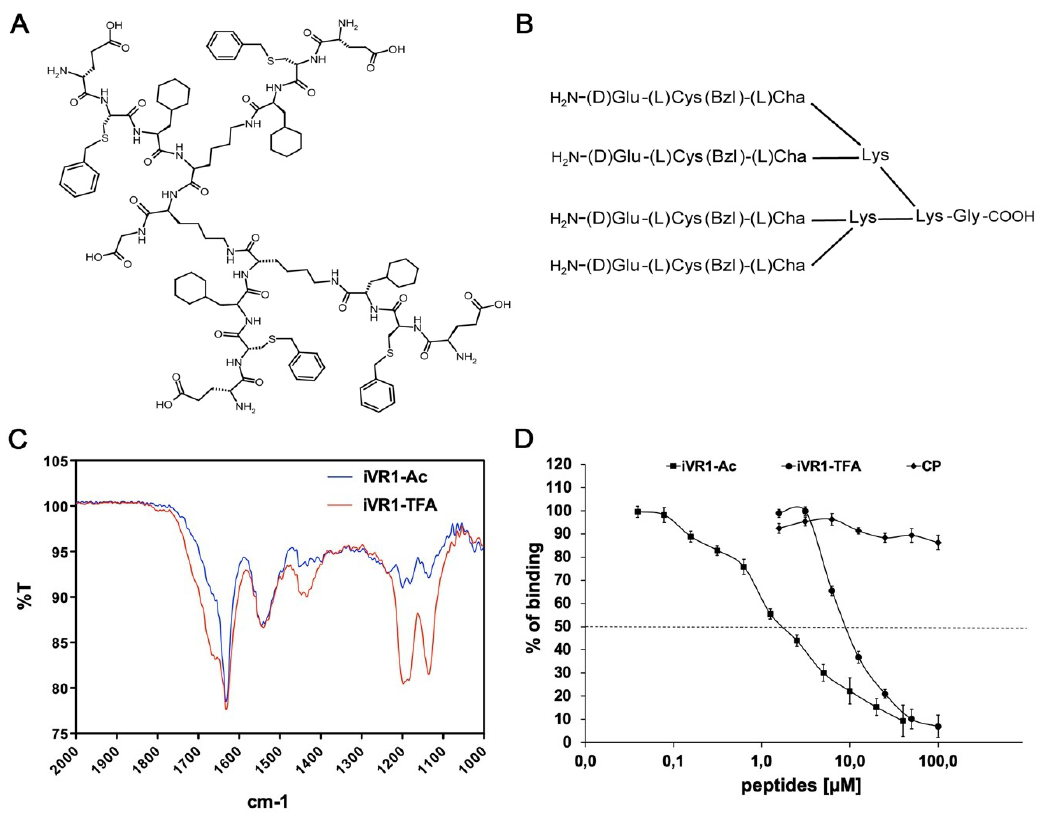
Figure 1. iVR1-Ac shows an increased inhibitory activity compared to iVR1-TFA. ( A ) Chemical structure of iVR1 tetrameric tripeptide that has a calculated molecular weight of 2362.02 g/mol. ( B ) Schematic representation of the iVR1. L-Cys(Bzl), L-cysteine(S-benzyl); L-Cha, L-cyclohexylalanine. ( C ) Overlay of FT-IR spectra in the spectral range between 1000 and 2000 cm –1 of the peptide before (red line) and after treatment with acetic acid (blue line). The spectrum collected on the acetic acid treated peptide shows that the bands characteristic of TFA at about 1145 and 1200 cm –1 are drastically reduced following repeated lyophilization in 0.1 M acetic acid. Some bands at around 1666 cm –1 were also strongly suppressed as consequence of the TFA removal. ( D ) Competitive ELISA for the binding of VEGF-A to immobilized VEGFR1. iVR1-Ac showed a decreased IC 50 as compared to iVR1-TFA (1.94 and 9.35 μM, respectively) estimated as the concentration at 50% inhibition. Control peptide (CP) was inactive in the concentration range tested (up to 100 μM). Data are presented as the mean ± SEM of two independent experiments performed in triplicate.